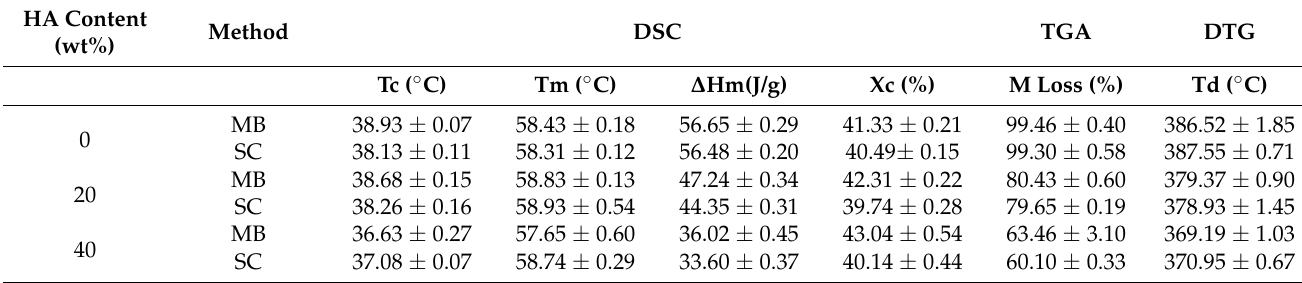
Table 1. Thermal properties of PCL and PCL/HA composites by DSC, TGA and